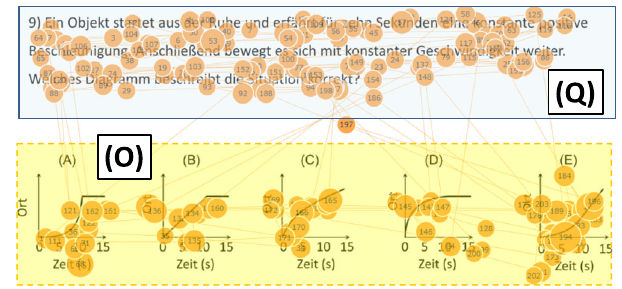
FIG. 2. Dendrogram illustrating the arrangement of the clusters produced by the hierarchical cluster analysis using the Ward